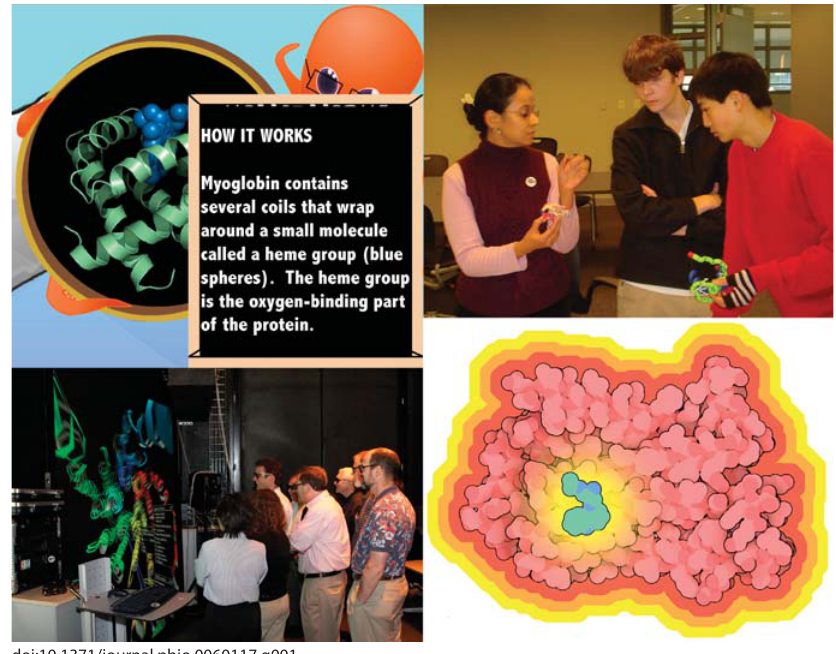
Figure 1. Examples of Education and Outreach